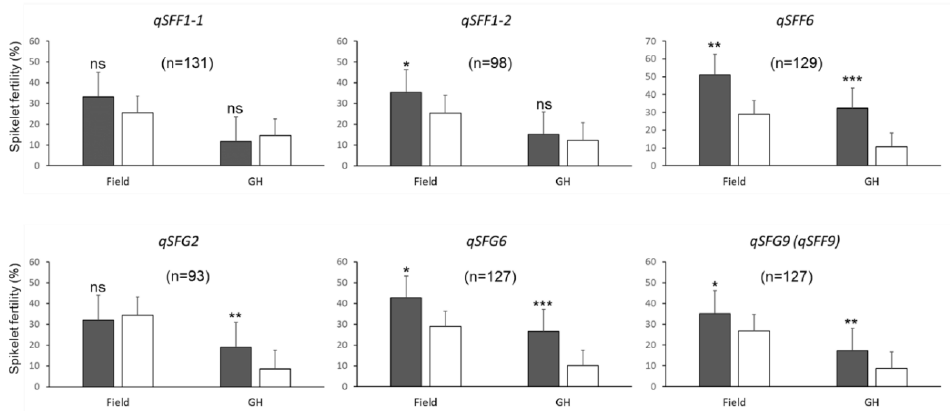
Figure 3. Effects of the cold tolerance QTL on spikelet fertility in cold-water-irrigated field and temperature-controlled greenhouse conditions. Gray bars and white bars indicate average spikelet fertility of RILs carrying alleles for cold tolerance and cold susceptibility at each locus, respectively. The alleles for cold tolerance were contributed by Giho at all QTL except for qSFF1-1 , at which Milyang23 provided the allele for cold tolerance (see Table 5). *, **, ***: significantly different at p < 0.05, p < 0.01 and p < 0.001 based on the t -test. ns: not significant. Error bars indicate standard deviations.